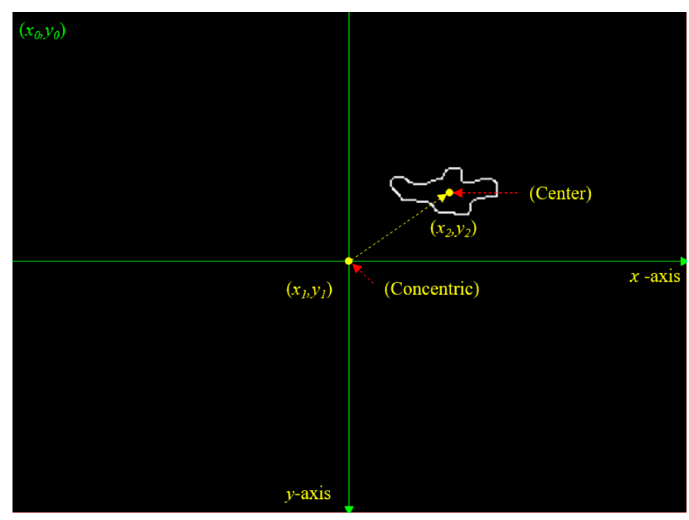
Figure 4. Diagram of the target drone displacement vector.